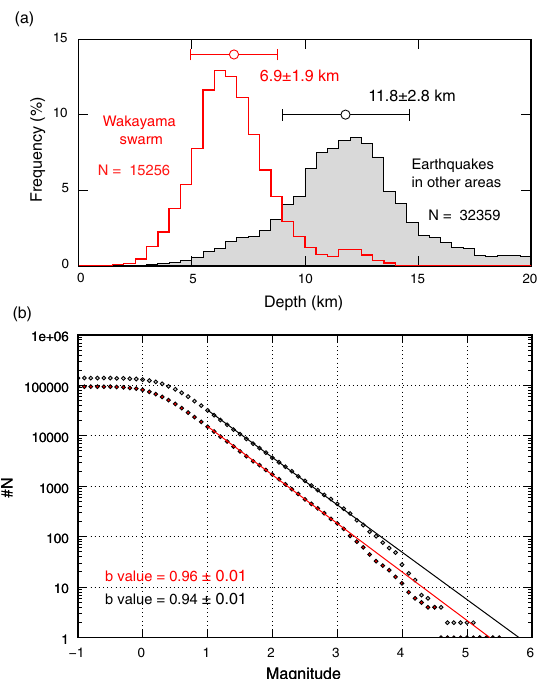
Fig. 3 a Frequency distribution of the focal depths of earthquakes in the Wakayama swarm (red) and in the areas surrounding the Wakayama swarm (gray). The hypocenter distributions are shown in Fig. 2a. Average focal depths and their associated standard deviations are indicated by the circle and error bars, respectively. b Magnitude– frequency distribution of the earthquakes in the Wakayama swarm (red) and in the surrounding areas of the Wakayama swarm